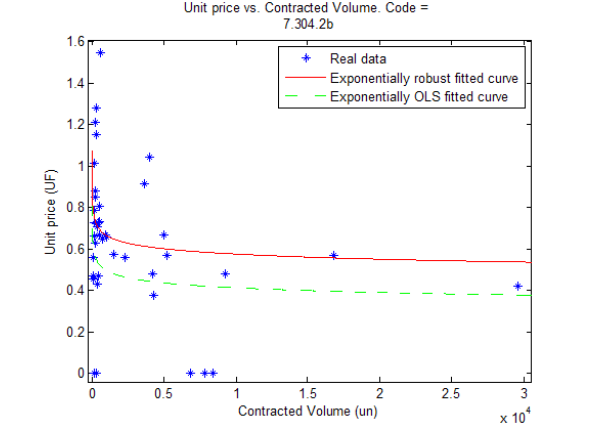
Fig. 2. Exponential decay of unit prices against contracted volume